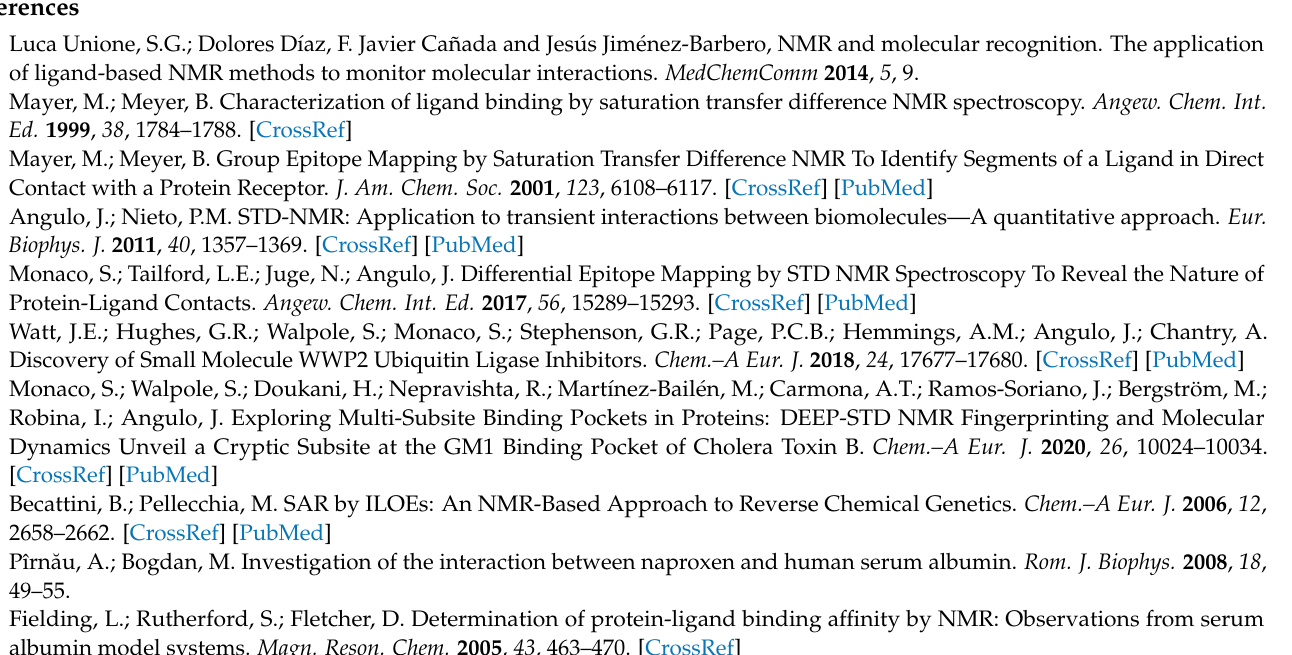
Figure S8: IL-STD NMR control experiments on binary complexes; Figure S9: negative IL-STD NMR control in the ternary complex; Table S1: IL-STD raw data BSA/NPX; Table S2: Definitions of STD NMR factors under different irradiation frequencies; Table S3: Definitions of IL-STD NMR factors; Table S4: Raw STD intensities 3NPG/CTB/1 ternary